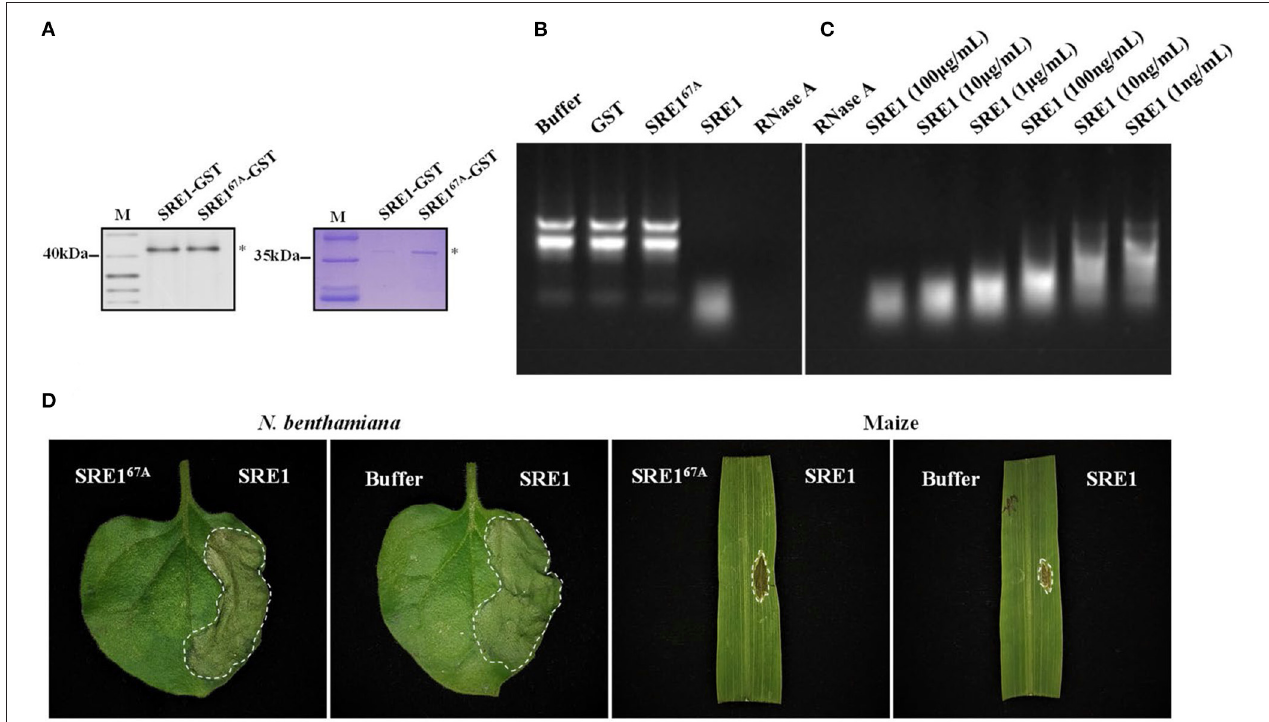
FIGURE 6 | SRE1 induces cell necrosis through the degradation of total plant RNA. (A) Coomassie brilliant blue detection and immunoblot analysis of SRE1-GST and SRE1 67A -GST. Asterisks represent the location of the target proteins. (B) Maize total RNA was used to determine the RNase activity of SRE1 and SRE1 67A recombinant proteins. Buffer and GST were negative controls, and RNase A was used as a positive control. The final concentrations of GST, RNase A, SRE1, and SRE1 67A were 100 µ g/mL. (C) Effects of different concentrations of SRE1 on the degradation of maize total RNA. (D) N. benthamiana and maize leaves were treated with recombinant proteins SRE1 and SRE1 67A at a concentration of 0.4 mg/mL. The buffer solution was used as a negative